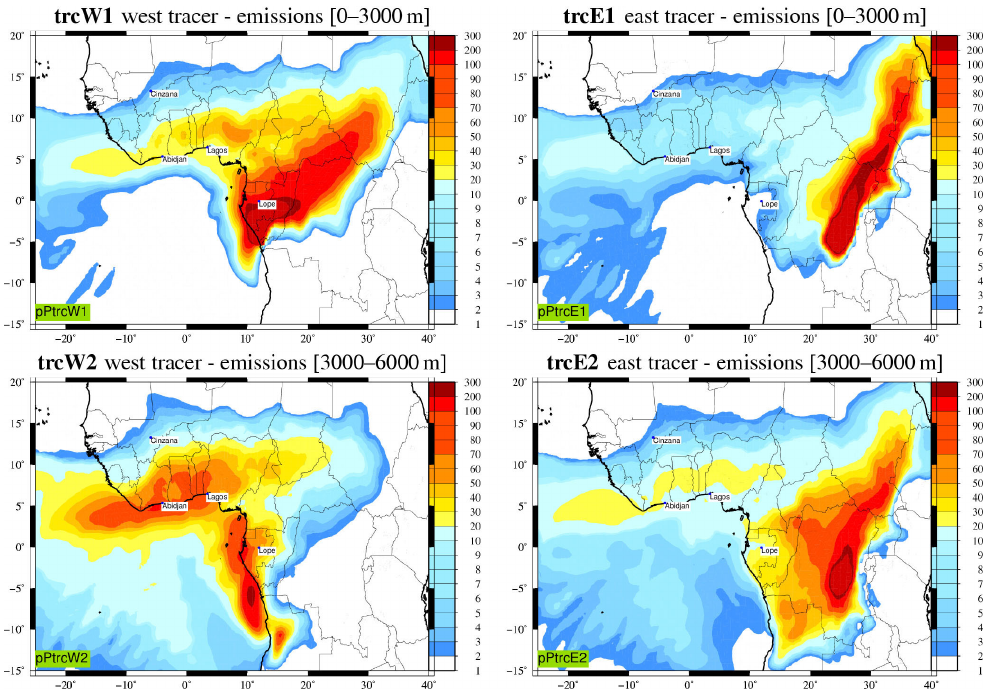
Figure 4. Regional distribution of tracer surface concentrations (arbitrary units) on 27 July 2014 at 12:00UTC for each of the tracer experi- ments, namely trcW1, trcW2, trcE1, and